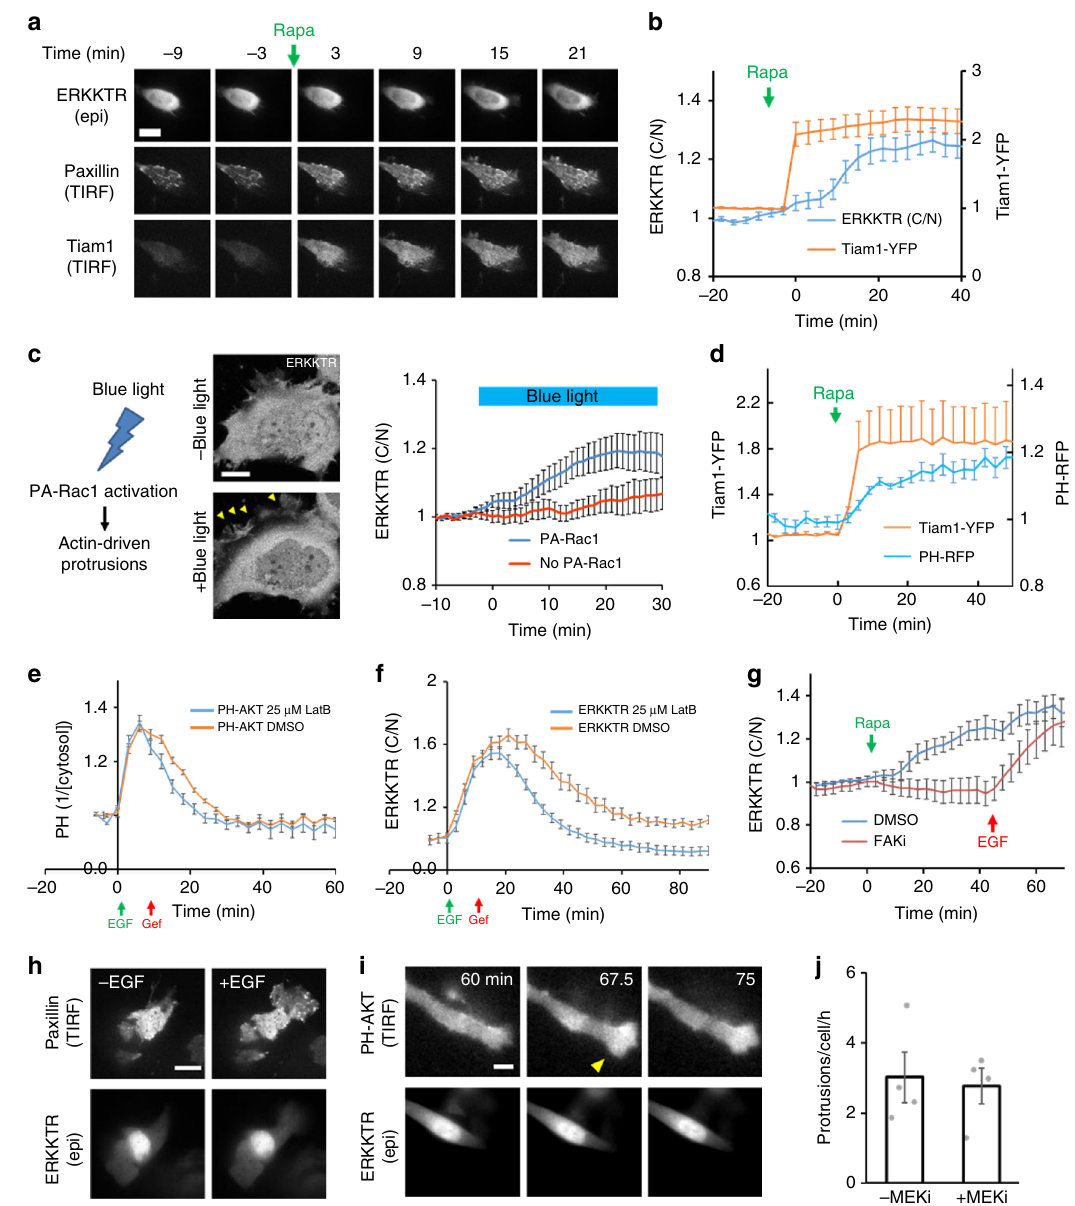
Fig. 4 ERK activation by arti fi cially induced protrusions. a , b Representative images for actin polymerization by CID of Tiam1 as well as the corresponding kinetics of YFP-FKBP-Tiam1 and ERKKTR responses (mean ± s.e.m., n = 19 cells). c Left: activation of PA-Rac1 by blue light induces actin polymerization and generation of protrusions. Middle: confocal images of a HeLa cell expressing ERKKTR and PA-Rac1 showing generation of protrusions (arrowheads) and nuclear exit of ERKKTR upon exposure to blue light. Right: kinetics of ERKKTR response to blue light in cells with (blue) or without (red) PA-Rac1 (mean ± s. e.m., n = 18 for PA-Rac1 and 16 for no PA-Rac1). d Kinetics of CID for Tiam1 and PH-AKT-RFP response (mean ± s.e.m., n = 6). e , f Responses of PH-AKT ( e ) and ERKKTR ( f ) to transient EGF stimuli (20 ng/ml EGF at 0 min followed by 1 µ M EGFR inhibitor ge fi tinib at 9 min) in the presence of 25 µ M Latrunculin B or DMSO (mean ± s.e.m.; normalized to pre-stimulus levels; n = 75 (DMSO) and 20 (LatB) cells for PH-AKT; n = 31 (DMSO) and 57 (LatB) for ERKKTR). g Response to CID of Tiam1 in HeLa cells pre-treated with DMSO or 10 µ M FAK inhibitor PF-573228 for 1 h (mean ± s.e.m., n = 10 cells each). EGF (100 ng/mL) stimulation was given at the indicated time point (red arrow). See Supplementary Figure 6e for a similar experiment using an alternative FAK inhibitor PF-562271. h An MCF7 cell treated with 10 µ M MEK inhibitor (MEKi, PD325091) for an hour and stimulated with 20 ng/ml EGF. i An SKOV3 cell treated with 1 µ M MEKi for a hour showing continued generation of protrusions (arrowheads, see Supplementary Movie 11 for an additional example). j Quanti fi cation of protrusion frequency by FDM (mean ± s.e.m., n = 4 experiments) in SKOV3 cells before and after treatment with the MEK inhibitor (1 µ M PD325901). Scale bars: 10 µ